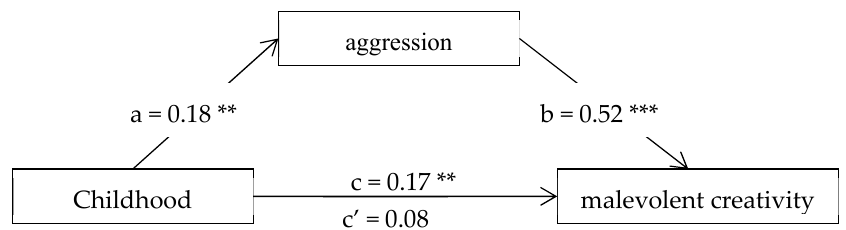
Figure 2. The mediation role of aggression between childhood trauma and malevolent creativity. Note. The mediation model was adjusted for the effects of gender, age, place of birth, and only child status. The letters a, b, c and c’ denote standardized regression coefficients: c = total effect